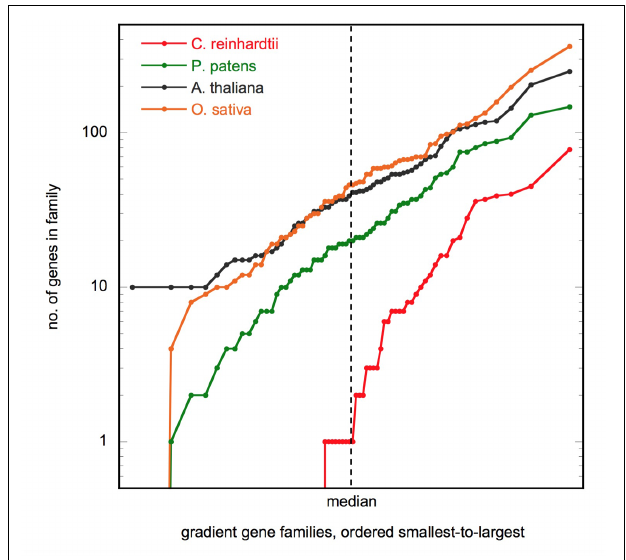
FIGURE 2 | Gene family size distribution. Plot shows the number of genes in the 66 gradient gene families, ordered smallest to largest, for the four species shown. The axes are scaled so that a log-normal distribution will appear as a straight line. Figure made using KaleidaGraph v4.5 (Synergy